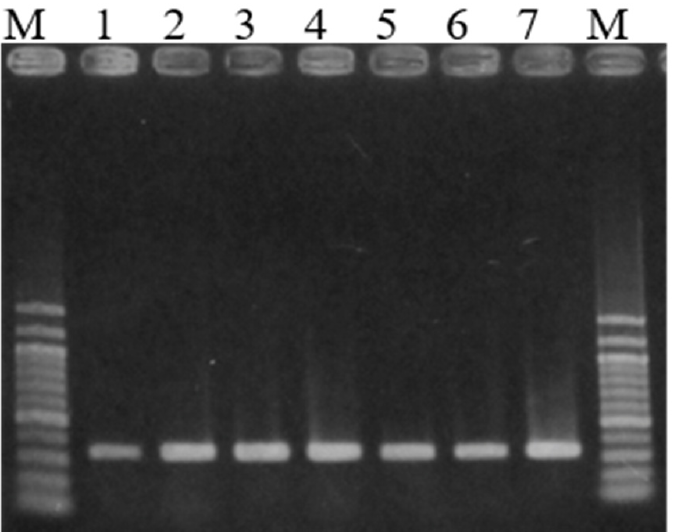
Figure 1. An example of PCR products analyzed by agarose gel electrophoresis. PCR was performed using samples obtained from chicken no. 1 (44 days old) on farm N. M, 100-bp ladder marker; 1, trachea; 2, lung; 3, liver; 4, spleen; 5, kidney; 6, pancreas; 7, rectum.